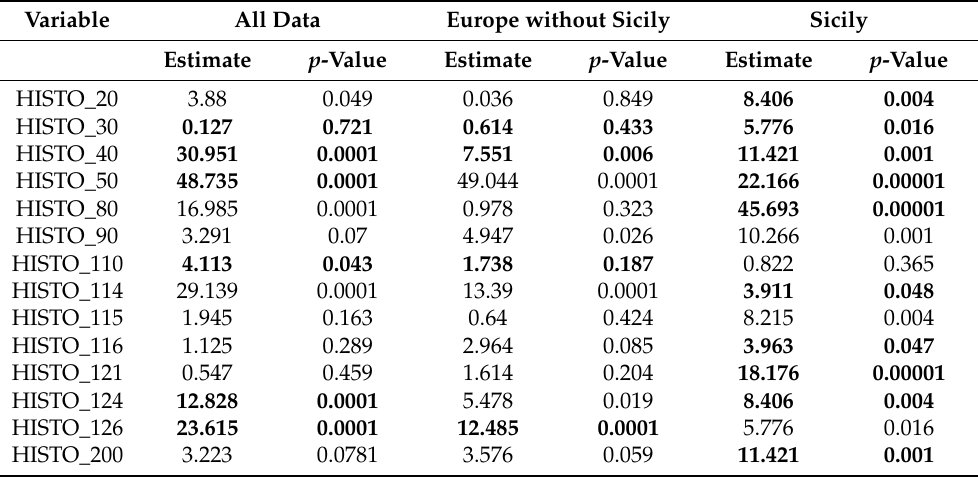
Table 2. Results of a logistic regression analysis on the relationship between Anoxia orientalis occur- rence and habitat characteristics (explained as land use CORINE categories) at different spatial scales (overall, in its European range and in Sicily). Significance is in boldface. Note that despite their p -value being <0.05, the significance of some variables disappeared after the Bonferroni correction was applied. Codes for the variables are as in Table 1.